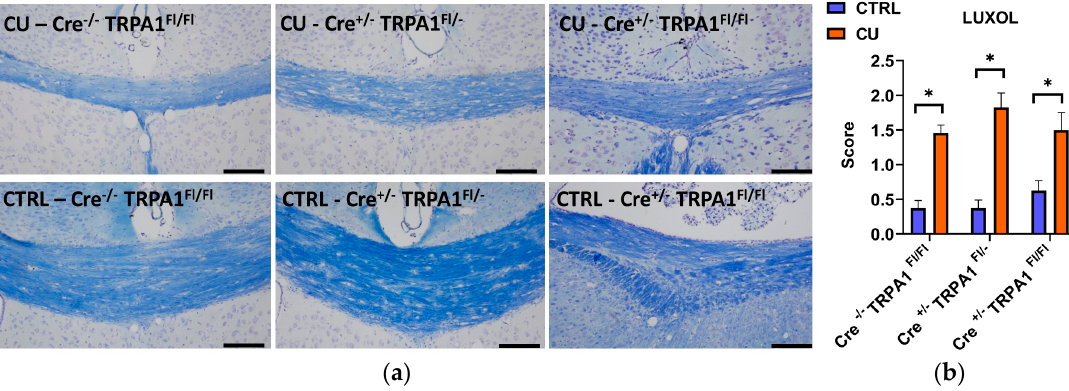
Figure 4. Evaluation of myelin content with Luxol Fast Blue/cresyl violet (LFB/CV) staining after 6 weeks of cuprizone treatment (a). Representative images of control (CTRL) and cuprizone-treated (CU) groups in GFAP-Cre − / − TRPA1 Fl/Fl , GFAP-Cre +/ − TRPA1 Fl/ − and GFAP-Cre +/ − TRPA1 Fl/Fl mice.; (b) Semiquantitative demyelination scores of LFB/CV staining, * p < 0.05, n = 3 – 5/group, Scale bar = 100 µm.